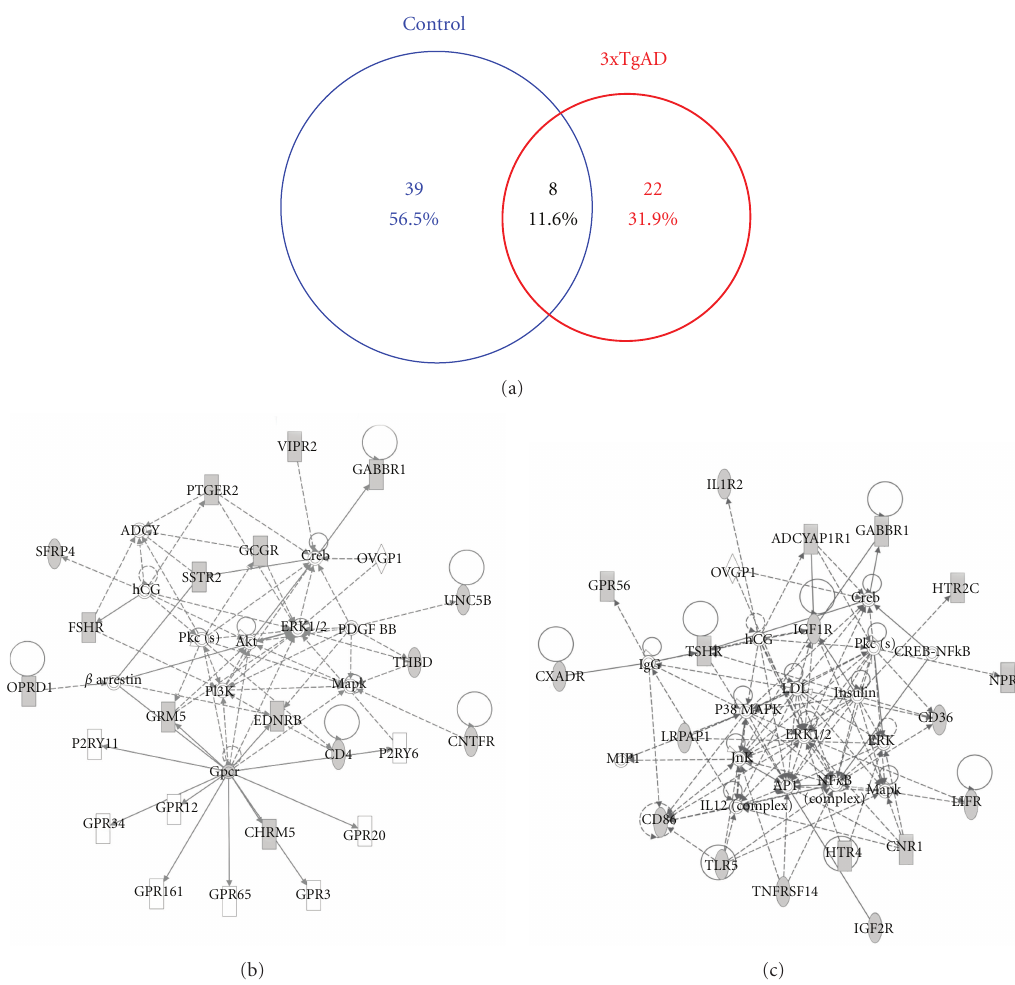
Figure 7: Receptor-restricted control and 3xTgAD network interaction analysis. (a) Proportionally drawn Venn diagram depicting the relative distribution between control or 3xTgAD raft samples of receptor-specific proteins filtered using IPA version 8.5 (control filtered protein list, Table 1; 3xTgAD filtered protein list, Table 2). (b) The highest scoring protein interaction network generated from IPA Network analysis (network scores and focus molecules are listed in Appendix I) of the receptor-specific control dataset. (c) The highest scoring protein interaction network generated from IPA Network analysis (network scores and focus molecules are listed in Appendix I) of the receptor-specific 3xTgAD dataset (Appendix J). A full description of the nature of interactions based on the connecting lines can be found at the following webpage linked to the IPA analysis module (https://analysis.ingenuity.com/pa/info/help/help.htm#ipa help.htm). Dashed lines represent indirect gene interactions while solid lines represent empirically measured direct interactions. The two highest significantly scoring networks (B—control, C—3xTgAD) are based on the highest percentage of the network occupation by specific proteins (focus molecules) from the input receptor-specific